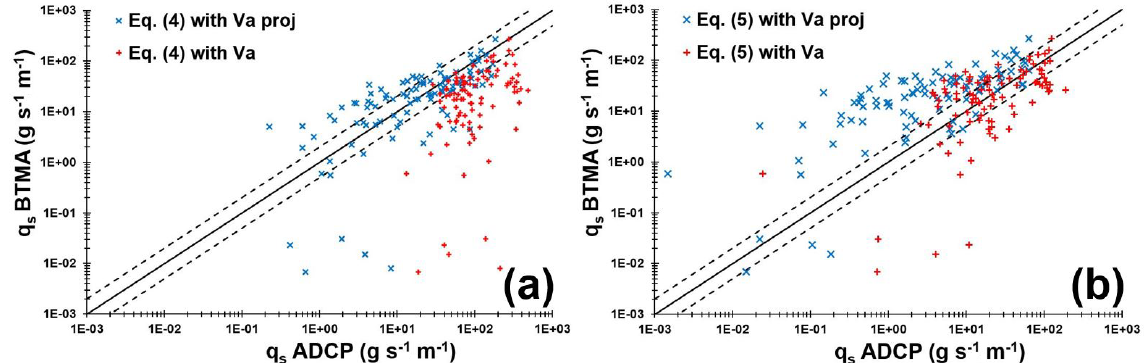
Figure 4. The log–log correlation between bedload rates measured with BTMA sampler and calculated using (a) Eq. (4) and (b) Eq. (5). The solid black line represents the perfect correlation and dashed black lines represent a factor of 2 above and below the perfect correlation.